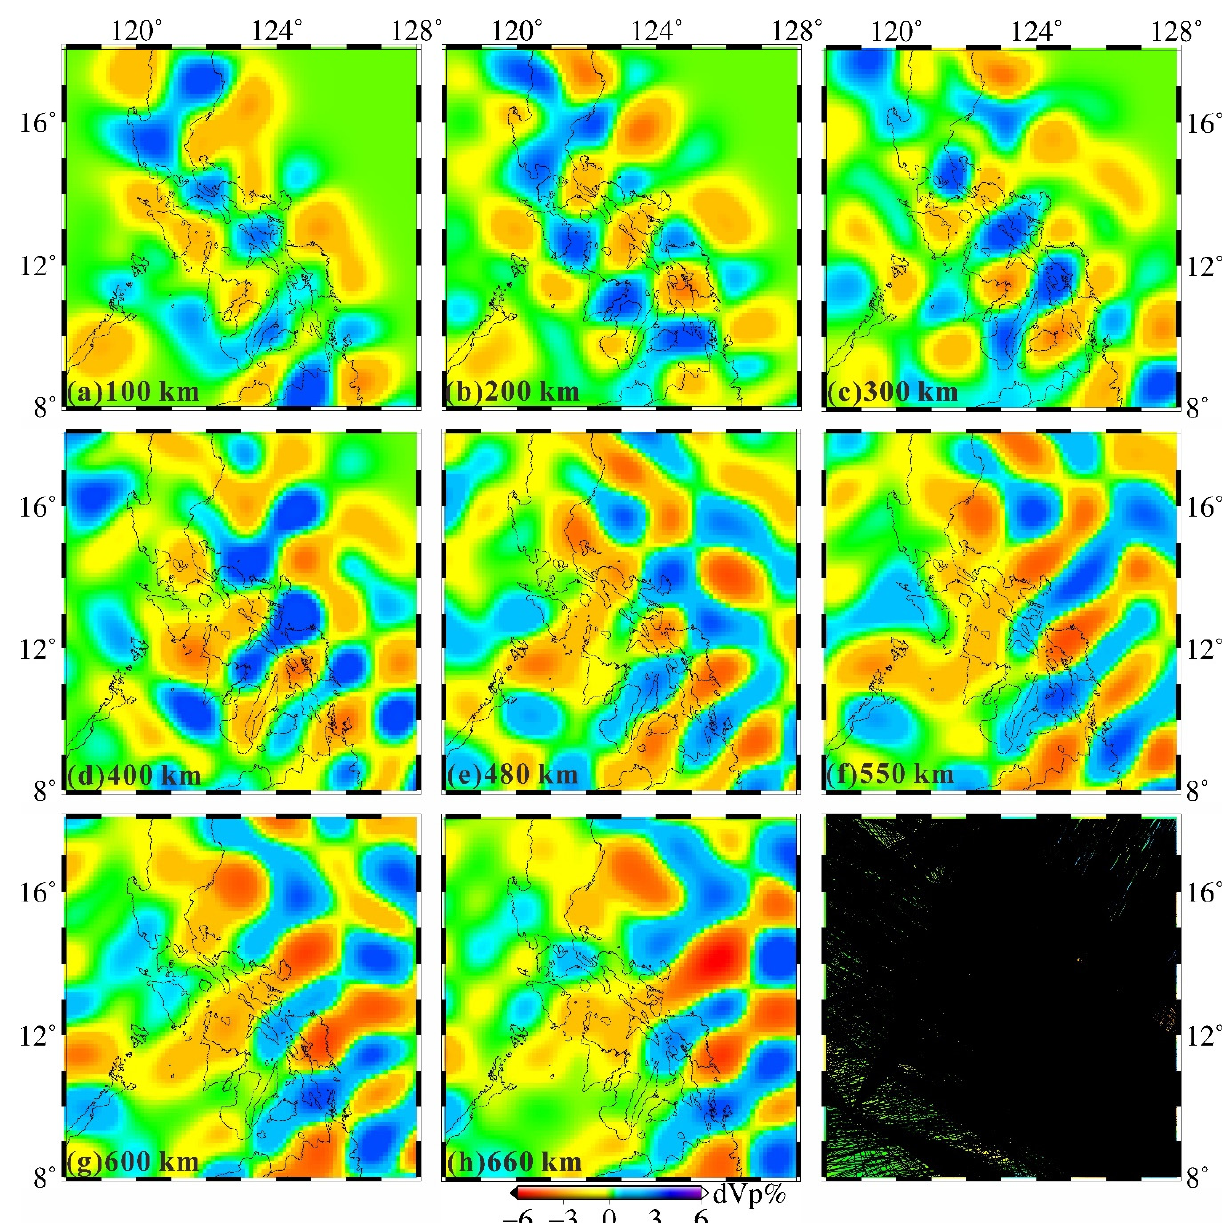
Figure 5. Checkerboard resolution test results in horizontal direction.